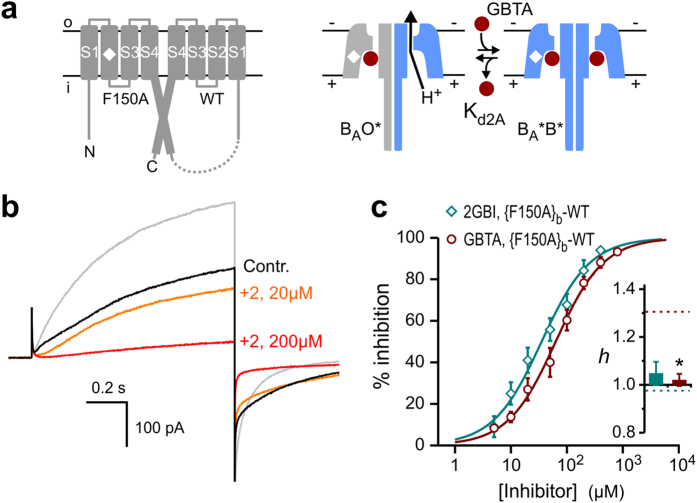
Binding of GBTA to blocked Hv1 hemichannels.(a) Schematics of the F150A-WT linked dimer used to generate blocked hemichannels ({F150A}b-WT/BAO*). White diamond shows position of mutation. The affinity of the F150A subunit is expected to be higher than the WT subunit in both the BAO* and BA*B* states. (b) Proton current from F150A-WT channels measured in response to a change in membrane potential from −80 mV to +120 mV. pHi = pHo = 6.0. Gray trace represents the current measured in the absence of inhibitor. Black trace (Control) represents the current measured after addition of 2 μM GBTA. At this concentration, the WT subunit is not significantly inhibited, while the F150A subunit is almost completely bound to GBTA ({F150A}b-WT). Further increase in GBTA concentration causes the block of the WT subunit (orange and red traces). (c) Concentration dependences of inhibition of the {F150A}b-WT dimer (with inhibitor pre-bound to the F150A subunit). Each point represents the average inhibition from 3 to 7 measurements ± S.D. Curve lines are Hill fits used to obtain the apparent Kd values reported in Supplementary Table 1. Hill coefficients shown in inset histogram were determined from fits reported in Supplementary Figs 3 and 4. Reference h values for Hv1 WT are shown as dotted lines. Asterisk indicates statistically significant difference compared to WT dimeric Hv1 (p < 0.05/14, see methods).